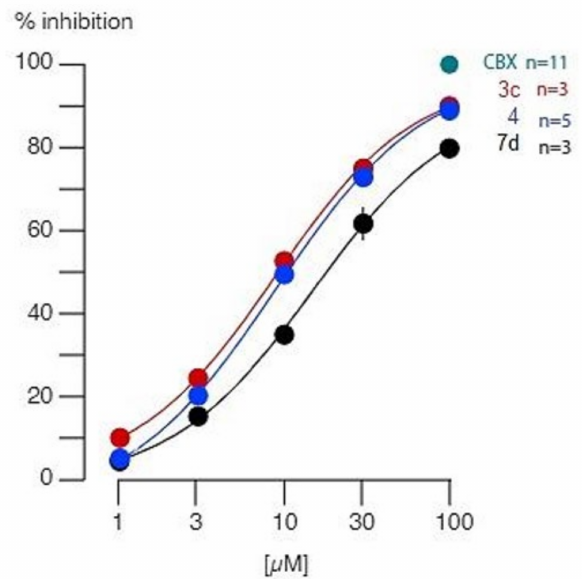
Figure 3. Quantitative analysis of the % inhibition of Panx1-mediated membrane currents in oocytes for compounds 3c , 4 and 7d . For reference, inhibition by carbenoxolone at 100 µ M, which is known to eliminate membrane currents mediated by Panx-1, was assessed for each oocyte at the end of each experiment after the test compounds induced inhibition. The number of oocytes used is indicated in the figure. The error bars in all instances were smaller than the symbol (with the exception of 30 µ M for 7d).